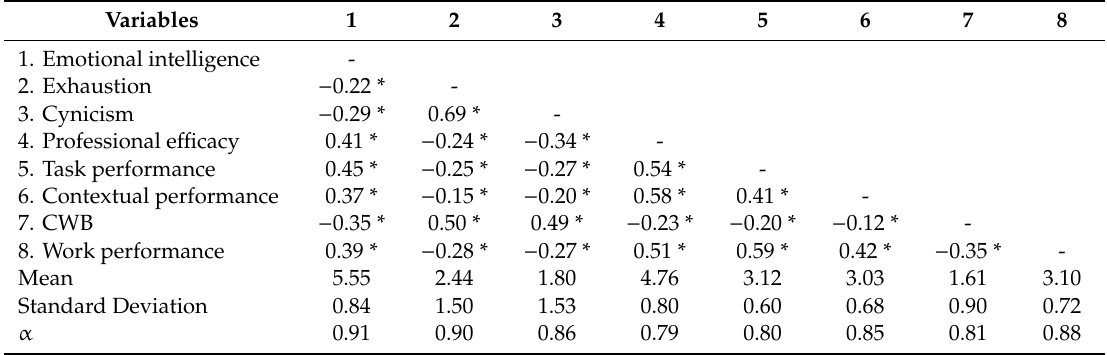
Table 2. Descriptive Statistics and Correlations between Study